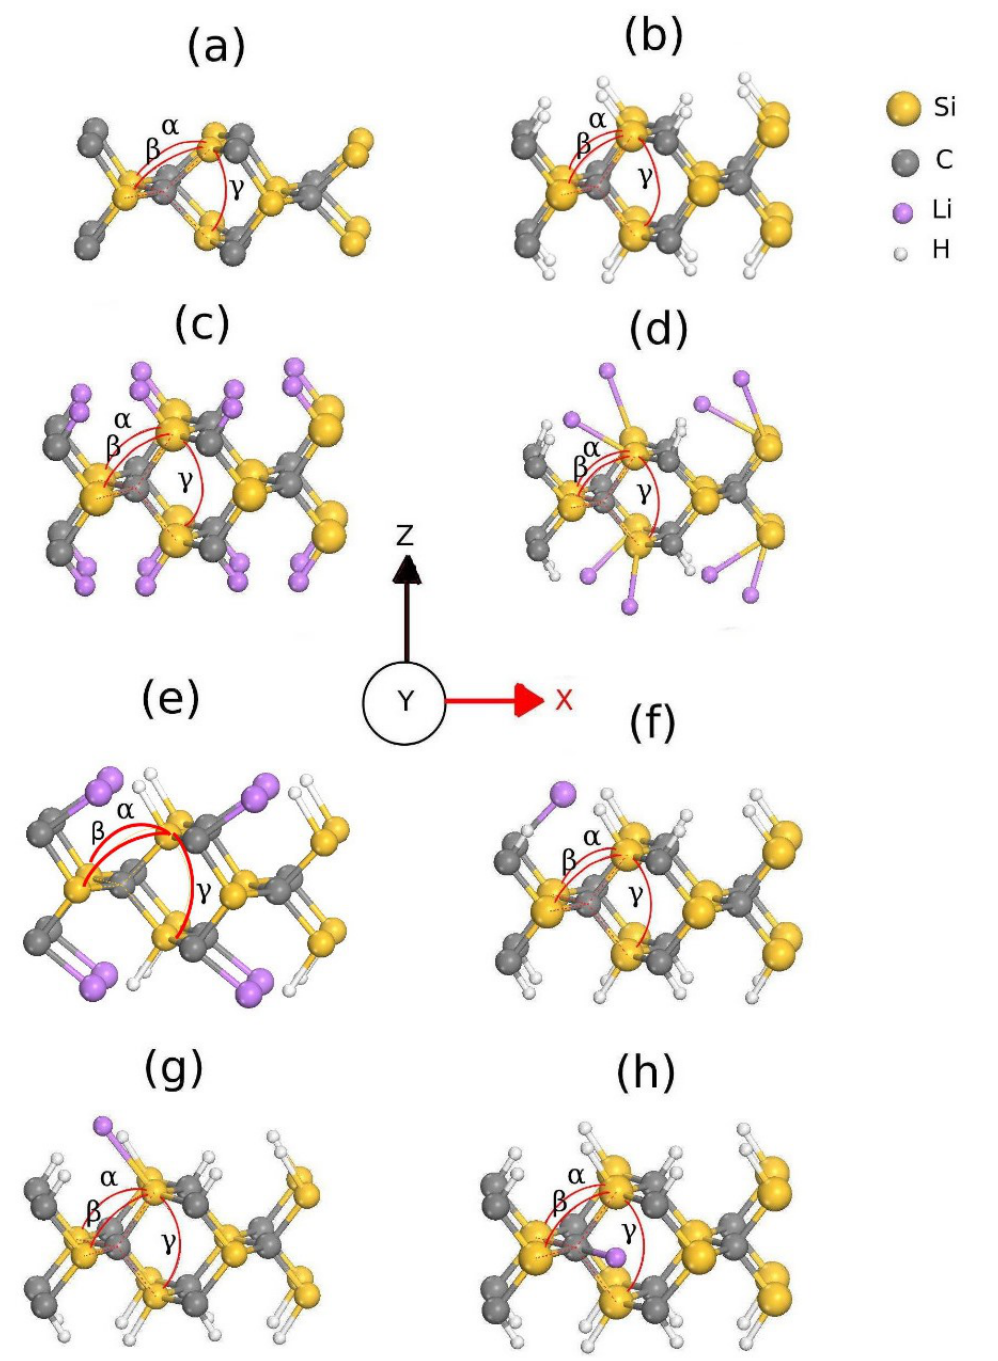
Figure 2. Schematic representation of 3C-SiC (1 1 0) monolayer with different passivations schemes after relaxation: ( a ) Pristine; ( b ) Full-H; ( c ) Full-Li; ( d ) CH+SiLi; ( e ) CLi+SiH; ( f ) H+1LiC; ( g ) H+1LiSi; ( h ) H+Li c . The grey, yellow, white, and purple spheres denote the C, Si, H, and Li atoms,